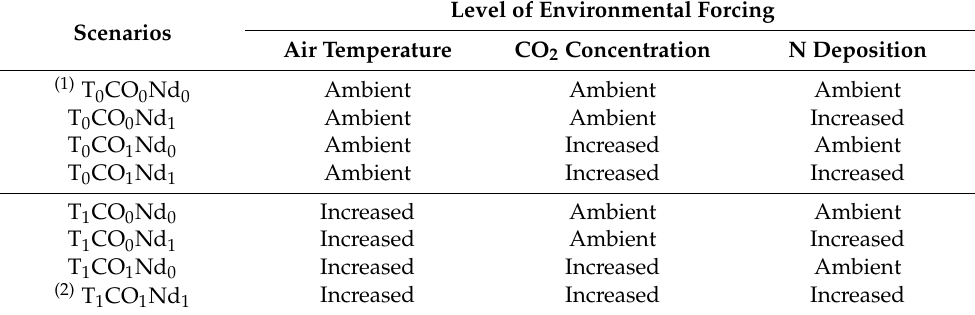
Table 1. Description of the eight forcing scenarios designed to assess the impacts of the national forest rehabilitation plan and human-induced environmental changes on the South Korean forests during